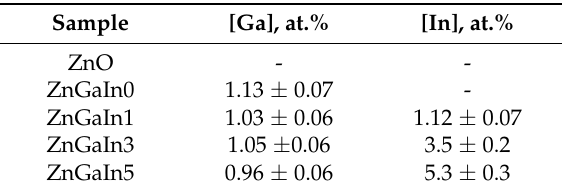
Table 1. Composition of the samples determined by ICP-MS. Sample [Ga], at.% [In],